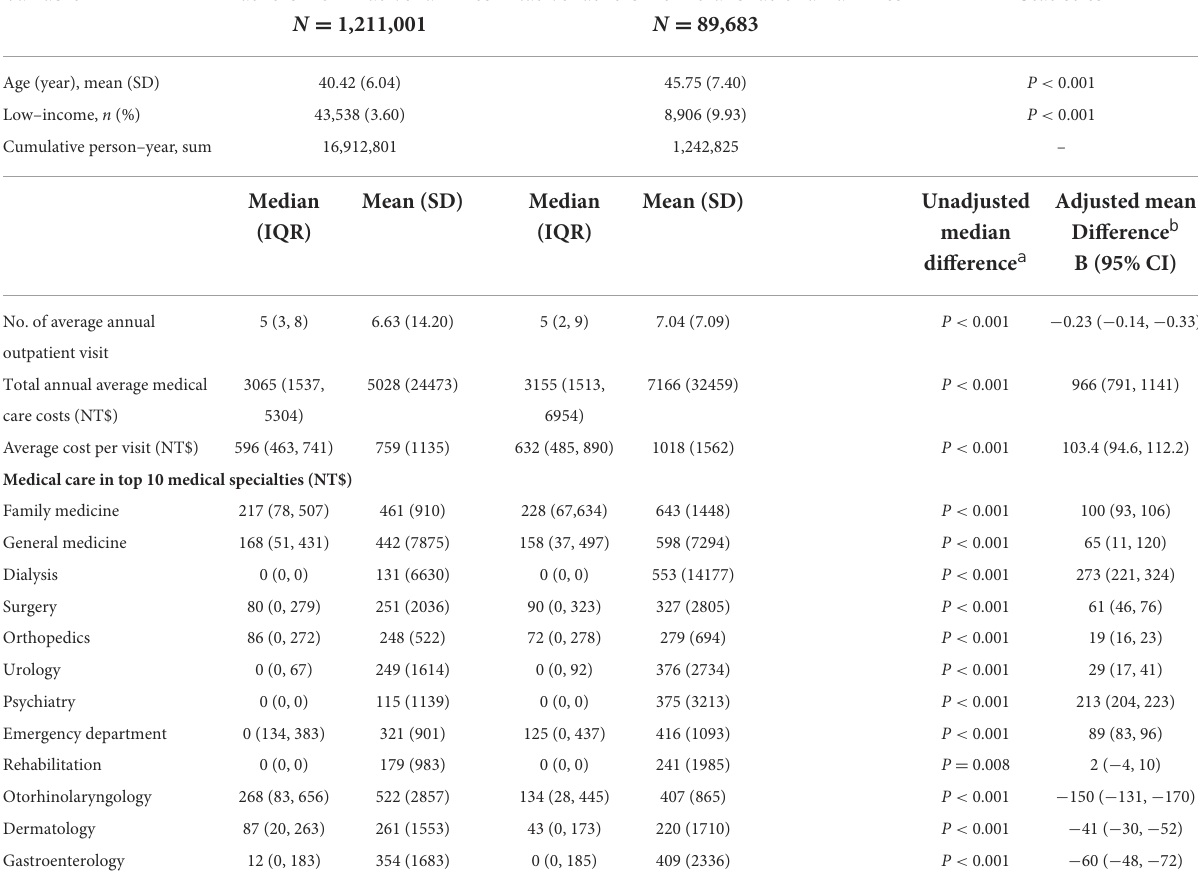
TABLE 1 Demographics, medical use and costs between fathers from transnational and native families. Variable Fathers from native families Native fathers from transnational